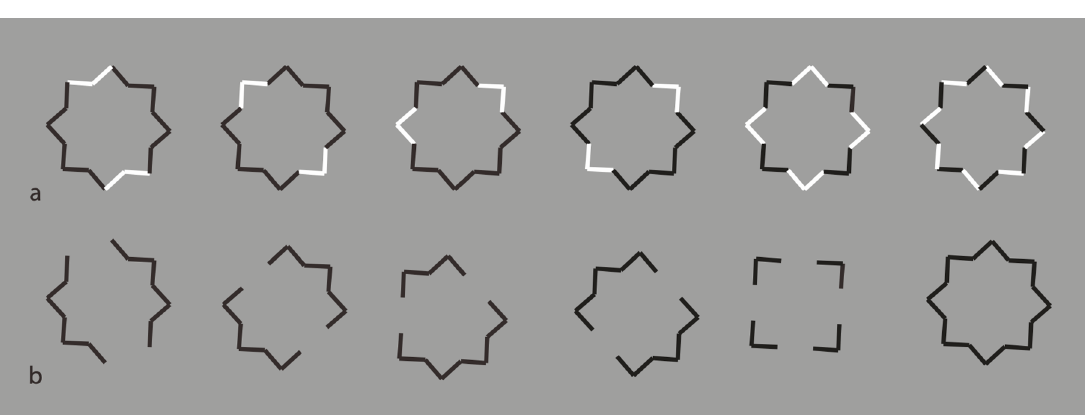
Figure 14. The black boundaries of a regular eight-pointed star discontinued by reversing the contrast polarity.